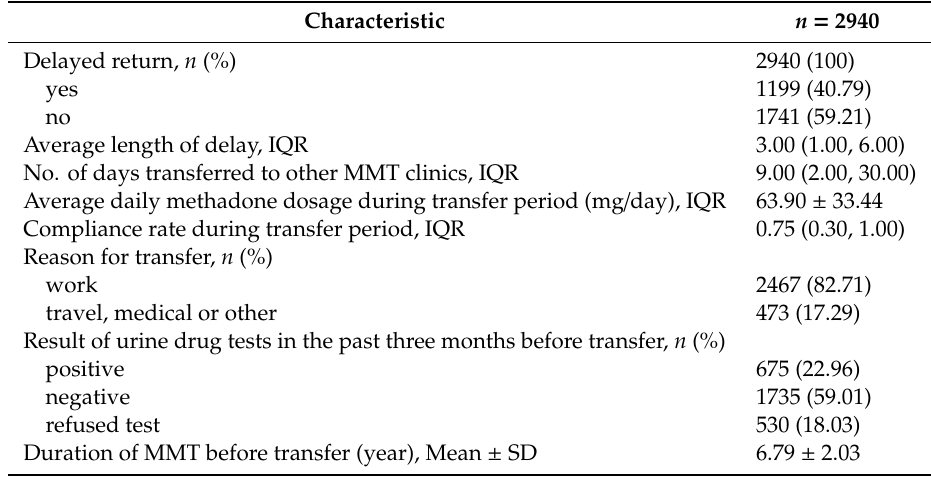
Table 2. The characteristics of each transfer (level